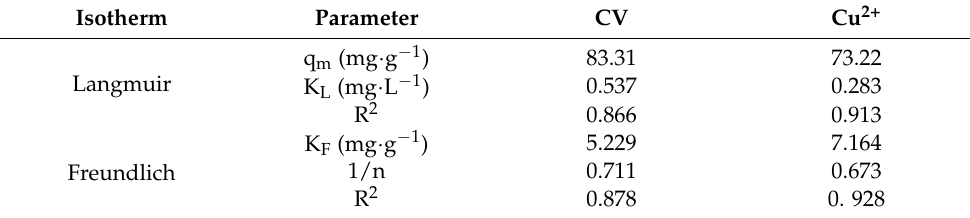
Table 3. The parameters of Langmuir and Freundlich isotherms for the adsorption of CV.